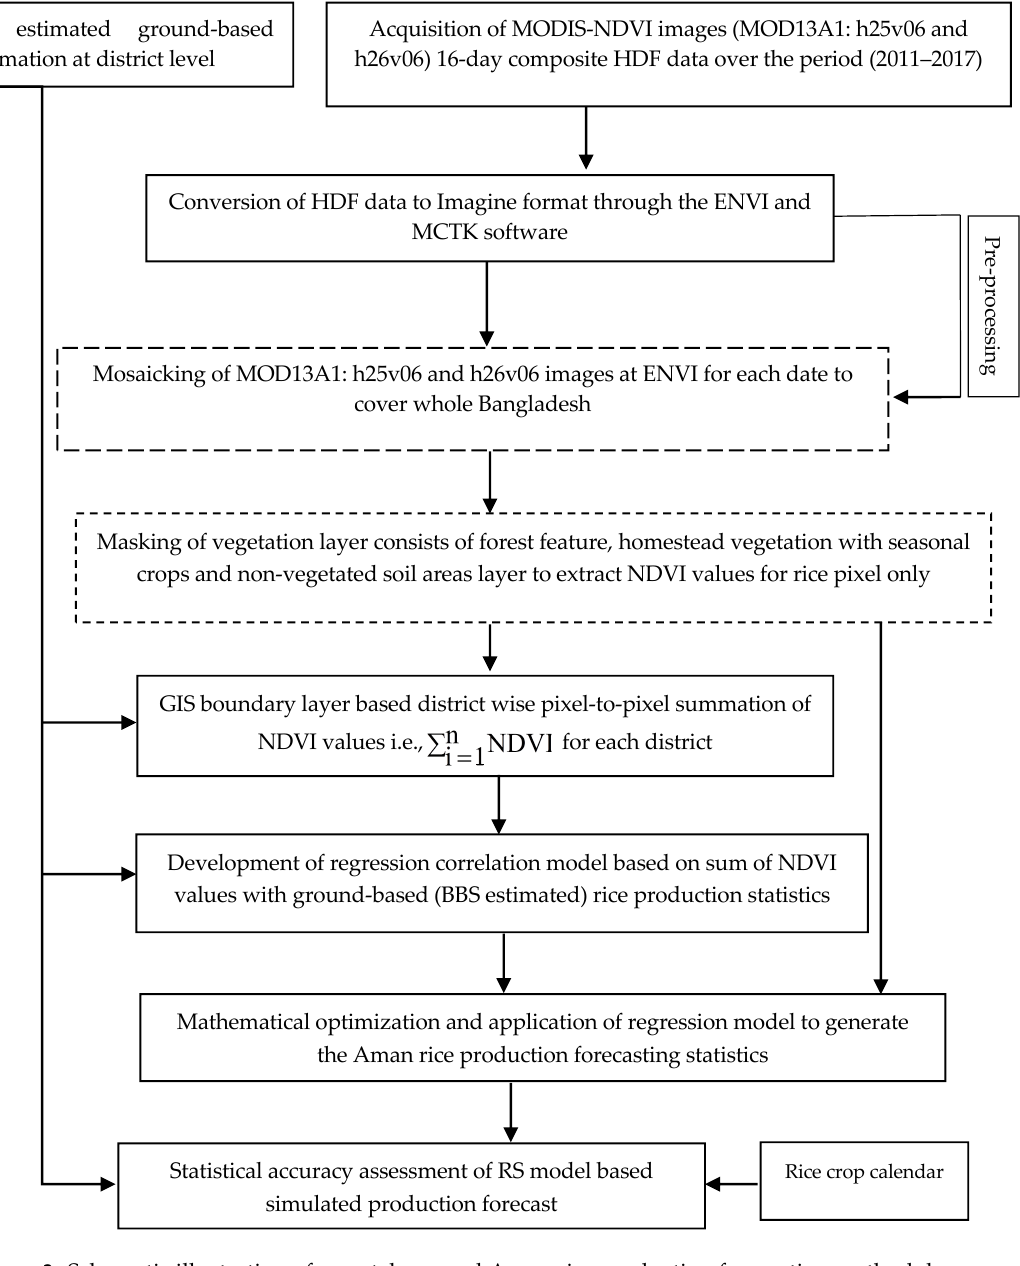
Figure 3. Schematic illustration of remotely sensed Aman rice production forecasting methodology (Note—RS: Remote Sensing; NDVI: Normalized Difference Vegetation Index; BBS: Bangladesh Bureau of Statistics; MCTK: MODIS Conversion Toolkit).